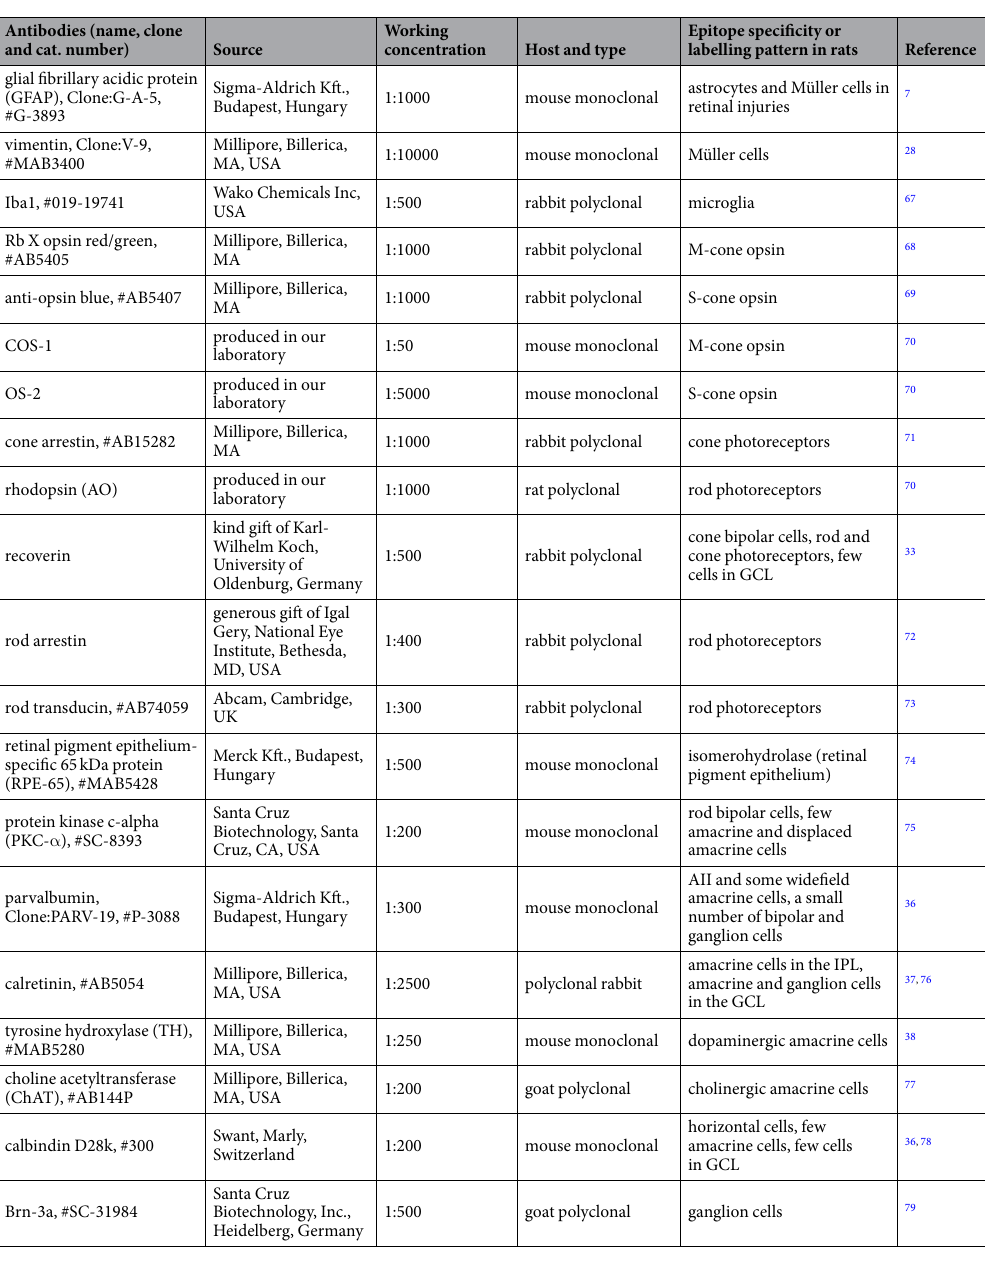
Table 1. Primary antibodies used in the